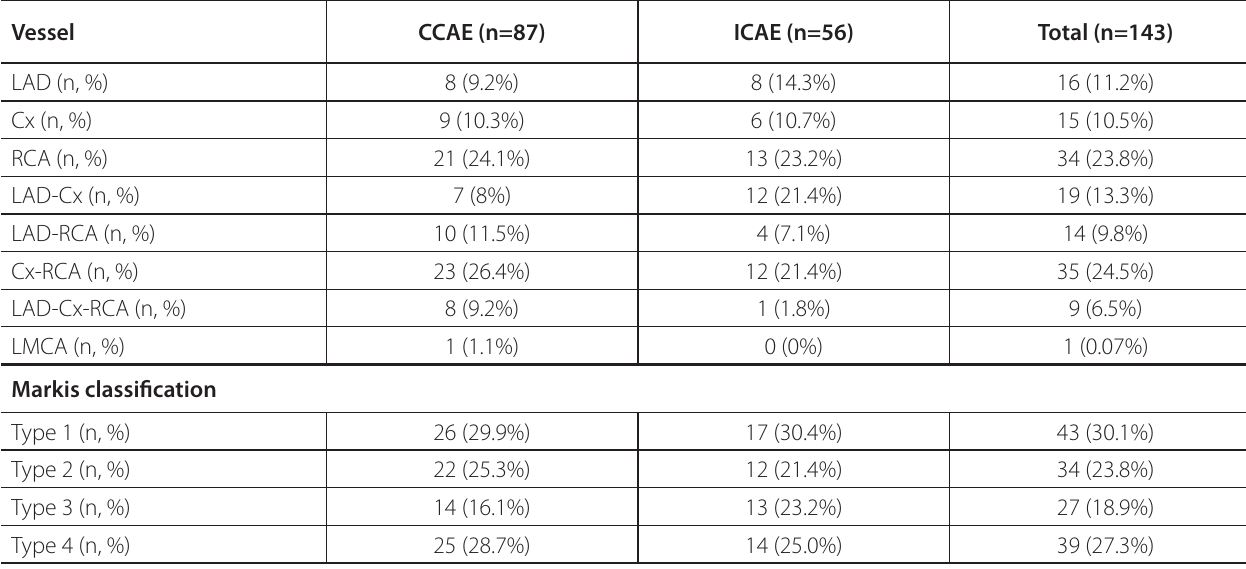
Table 1 . Ectatic lesions, coronary vessels and Markis classification.